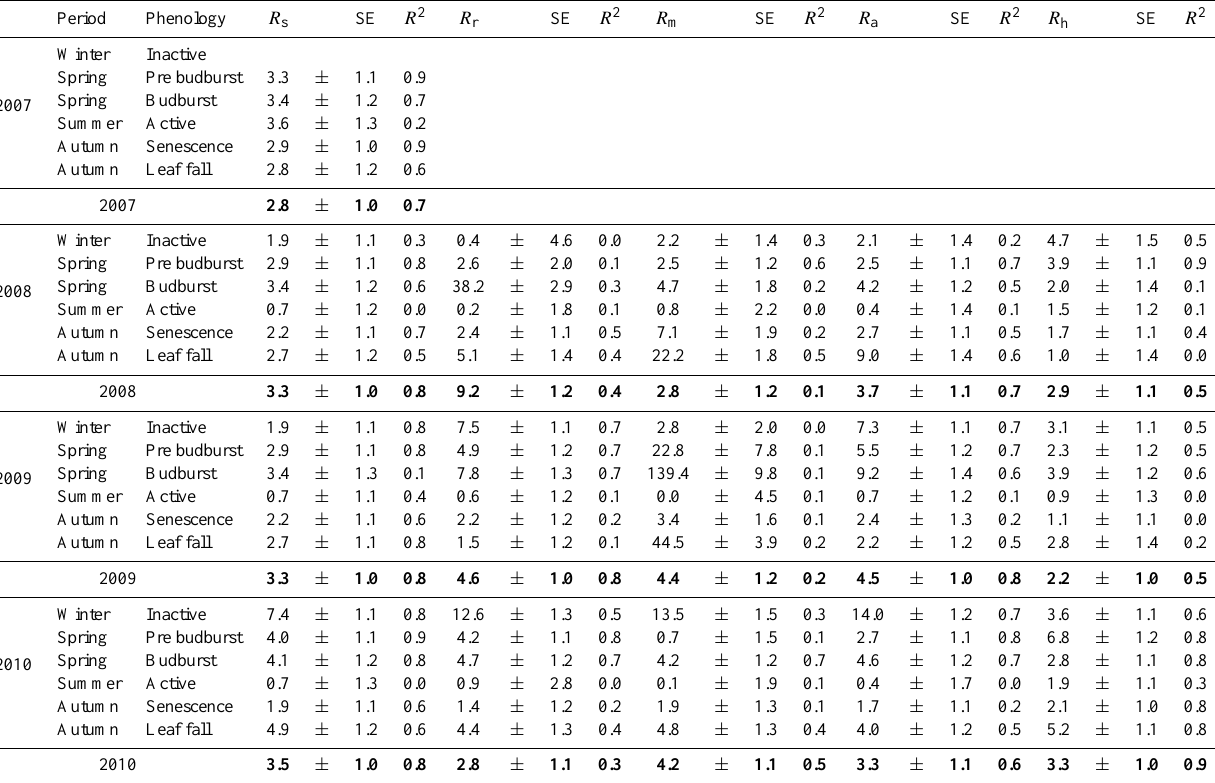
Table 5. Seasonal and annual average apparent Q 10 values (with ± SE and R 2 ) derived from daily total soil respiration, R s , and its component fluxes over particular phenological periods at the Straits Enclosure, Alice Holt forest from 2007 to 2010. Q 10 values calculated from the slopes of linear (best fit) regressions of log 10 transformed CO 2 fluxes (after Atkin et al., 2000), against either the soil temperature at 2cm soil depth for R s and R h or soil surface temperature for R a , R r and R m . Phenological periods (for tree canopy) are defined in Table 4. Abbreviations defined in Table 3; blank entries are due to no